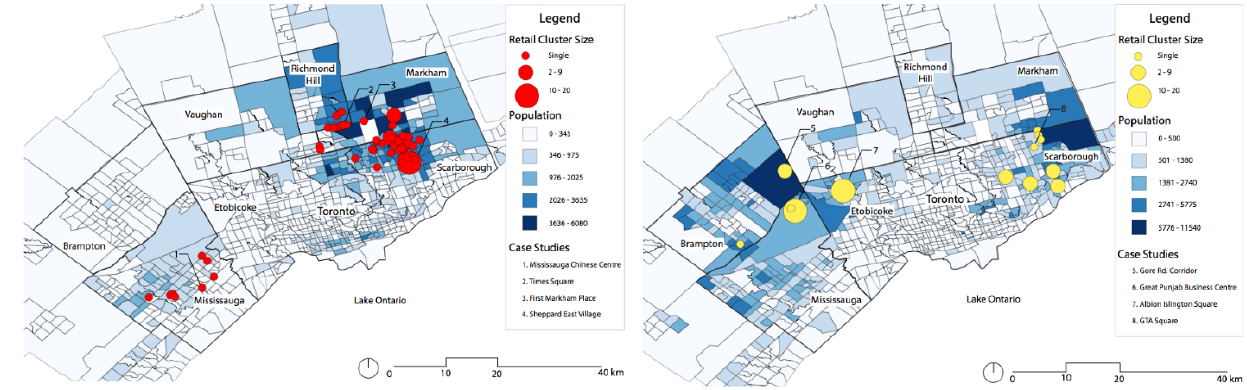
Figure 1. Locations of the eight case studies in relation to Chinese (left) and South Asian (right) populations and retail clusters in the Toronto Census Metropolitan